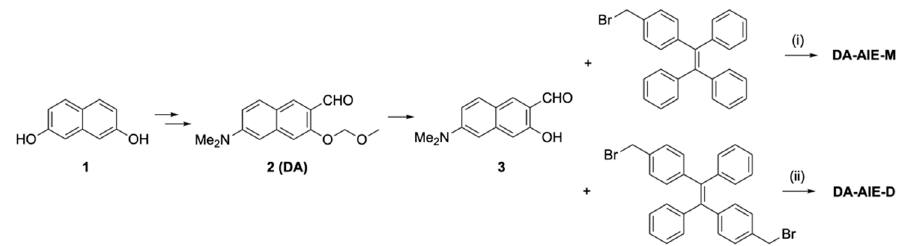
Figure 2. Synthetic scheme for DA-AIE-M and DA-AIE-D. Reagents and conditions: ( i ) NaH, DMF, 25 °C, 1 h, 58%; ( ii ) NaH, DMF, 25 °C, 1 h, 30%.